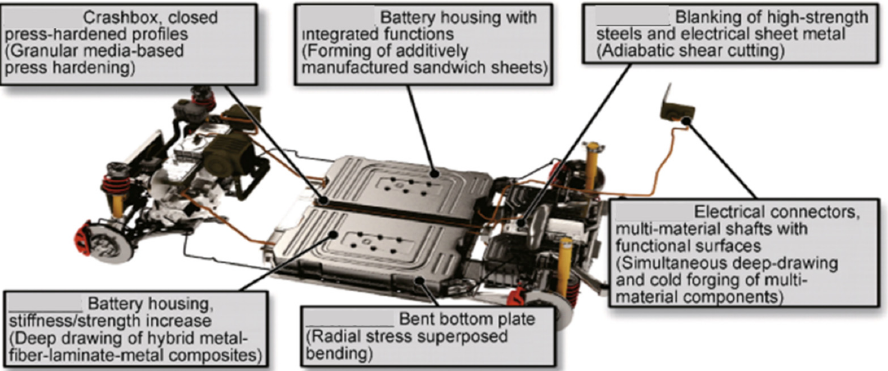
Figure 6. Examples of manufacturing processes that can be used for the lightweight components of electric vehicles [26].